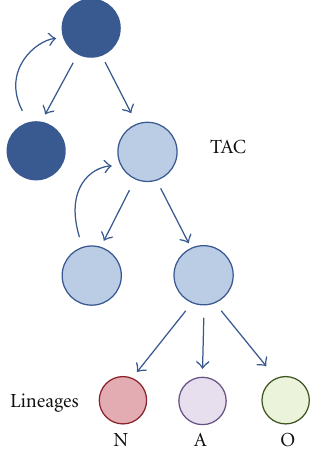
Figure 1: The dynamics of proliferation and di ff erentiation in the adult neurogenic niches. Neural stem cells (NSCs) divide, both symmetrically and asymmetrically for self-renewal and production of transit amplifying cells (TACs). The term neuroprogenitors encompasses TACs and true NSCs. TACs rapidly divide symmet- rically to amplify the availability of neural and glial precursors and finally di ff erentiate into one of the three neural lineages: neuronal (N), astroglial (A), or oligodendroglial